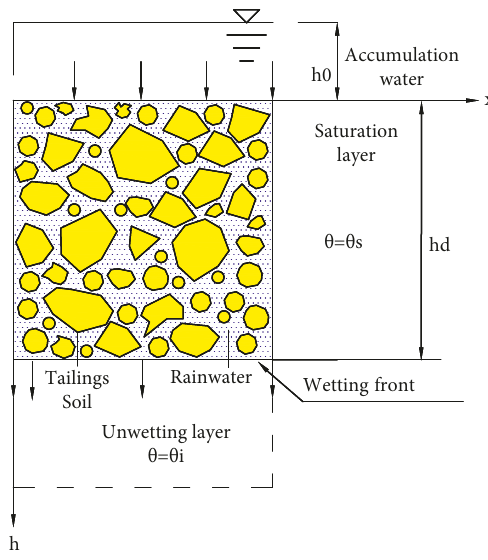
Figure 1: The schematic diagram of GA infiltration